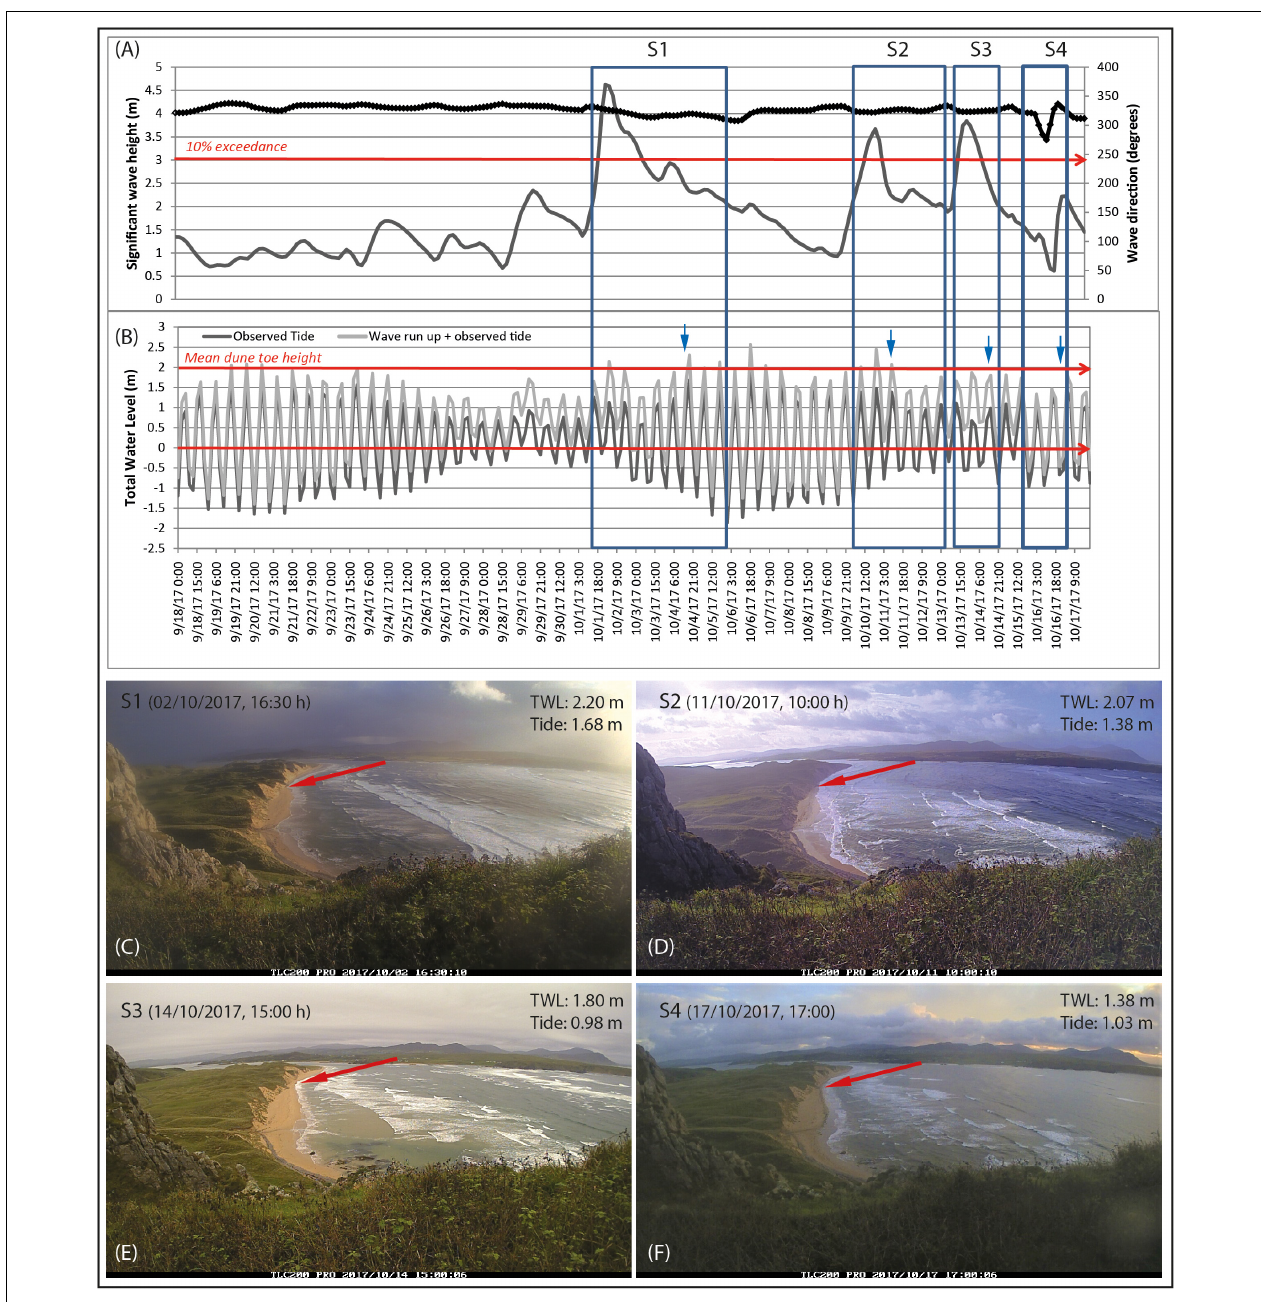
FIGURE 5 | (A) Shows the wave climate time-series spanning Storm Ophelia where the left Y-axis accounts for H s (grey line) and right Y-axis represents wave direction in degrees (top black line). Graph (B) represents the Total Water Level (TWL) based on wave run-up for each storm event (from Guisado-Pintado and Jackson, 2018) where blue arrows show the water level position from the time-lapse camera pictures. Squares highlight storm events that occurred between TLS/topographic surveys with S4 corresponding to Storm Ophelia. Pictures (C–F) show corresponding time-lapse images where peak storm wave height and/or the highest synchronisation of both wave height and water level during each storm analysed (S1–S4). Note that red arrows point to the maximum wave run